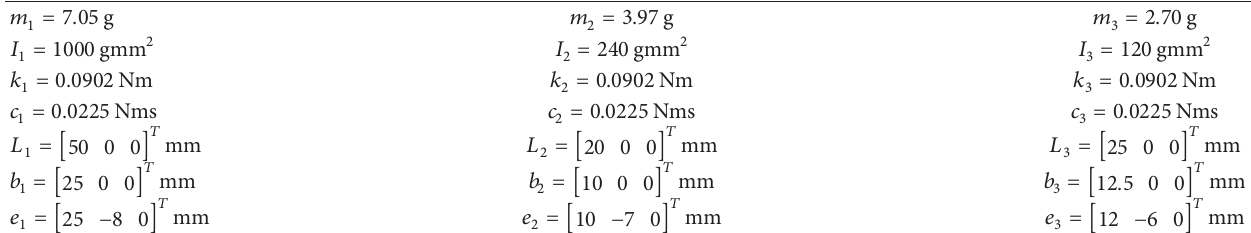
Table 11: Anthropometric data and numerical constants used for